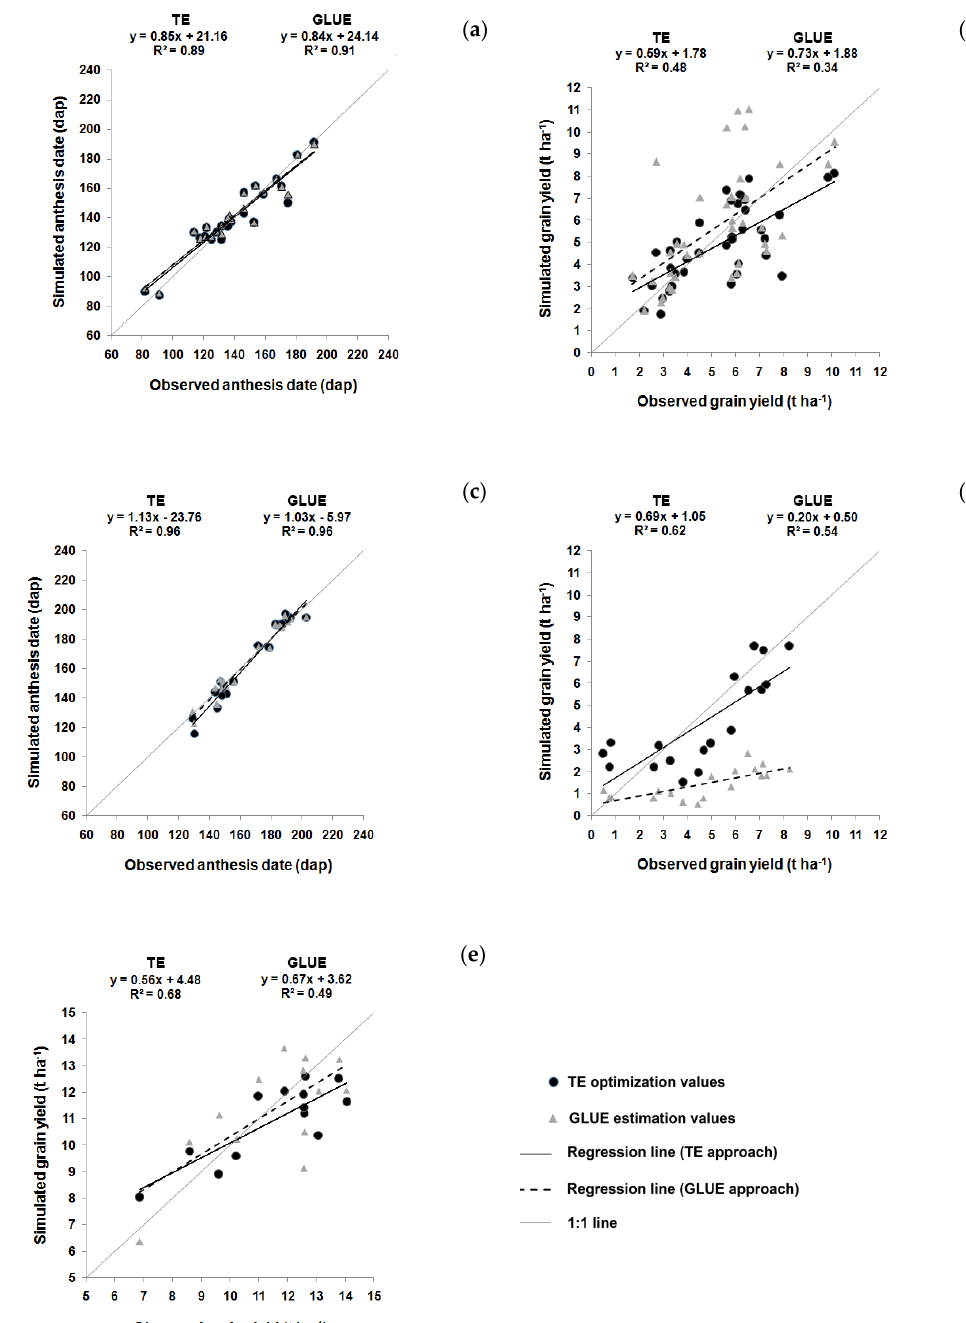
Figure 2. Calibration results for anthesis date ( a ) and grain yield ( b ) of durum wheat (Iride cv), anthesis date ( c ) and grain yield ( d ) of common wheat (Bologna cv), and grain yield of maize (Eleonora hybrid) ( e ) with TE and GLUE methods.